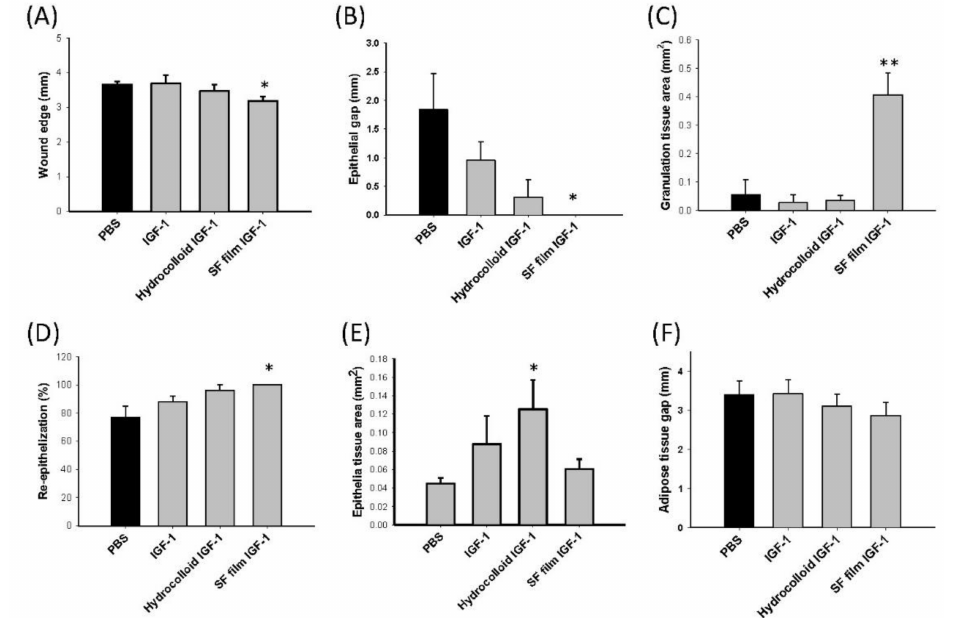
Figure 6. Analysis of tissue regeneration in diabetic wounds treated with PBS (control), native insulin- like growth factor 1 (IGF-1), a commercial dressing product (hydrocolloid IGF-1), and insulin-like growth factor 1-loaded silk fibroin films (SF film IGF-1). ( A ) Quantification of wound edge distance, ( B ) epithelial gap, ( C ) granulation tissue area, ( D ) re-epithelialization, ( E ) epithelial tissue area, and ( F ) adipose tissue gap following wound healing 13 days post-wounding. Significant differences between PBS (black bar) and other treatments were determined using Dunnett’s multiple comparison post hoc test. * p < 0.05, ** p < 0.01; n = 5; ±